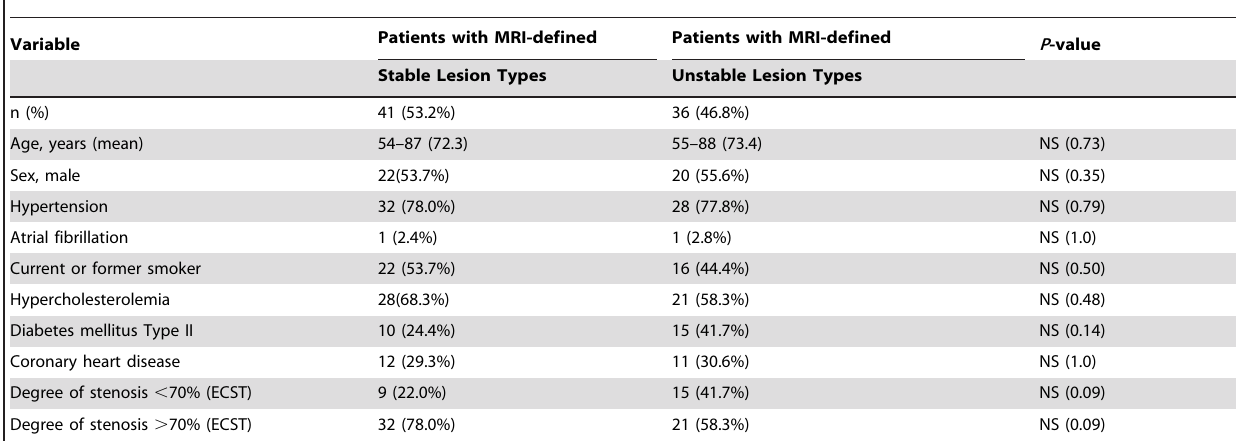
Table 2. Demographic variables in the group of patients with MRI-defined stable and unstable lesion types.